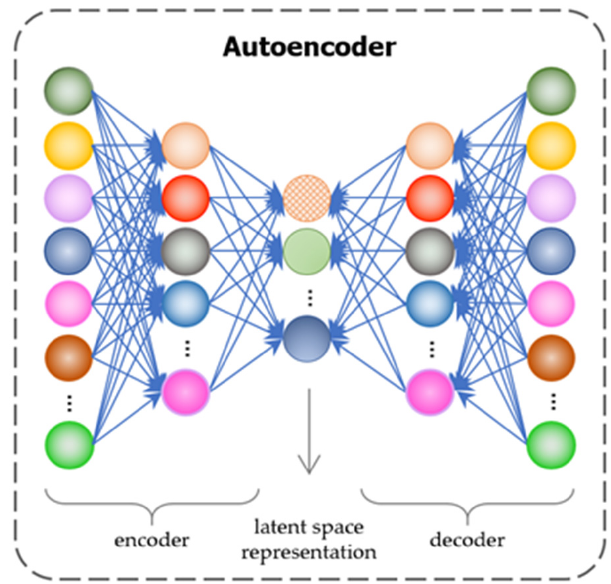
Figure 5. The architecture of the auto-encoder model.